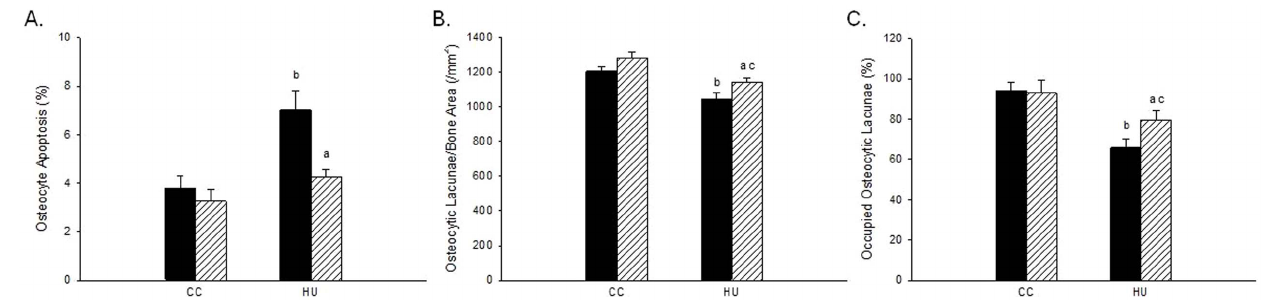
Figure 6. Effects of dobutamine (DOB) or vehicle (VEH) administration during hindlimb unloading (HU) or ambulatory cage activity (CC) on cancellous bone osteocytes measured at the distal femur. A : TUNEL + osteocytes (%). B : Total number of osteocytic lacunae (N.Ot/ B.Ar). C : Osteocyte occupancy frequency (%). VEH groups are represented by black bars; DOB groups are represented by striped bars. a HU + DOB vs. HU + VEH (p # 0.05); b HU + VEH vs. CC + VEH (p # 0.05); c HU + DOB vs. CC + DOB (p #